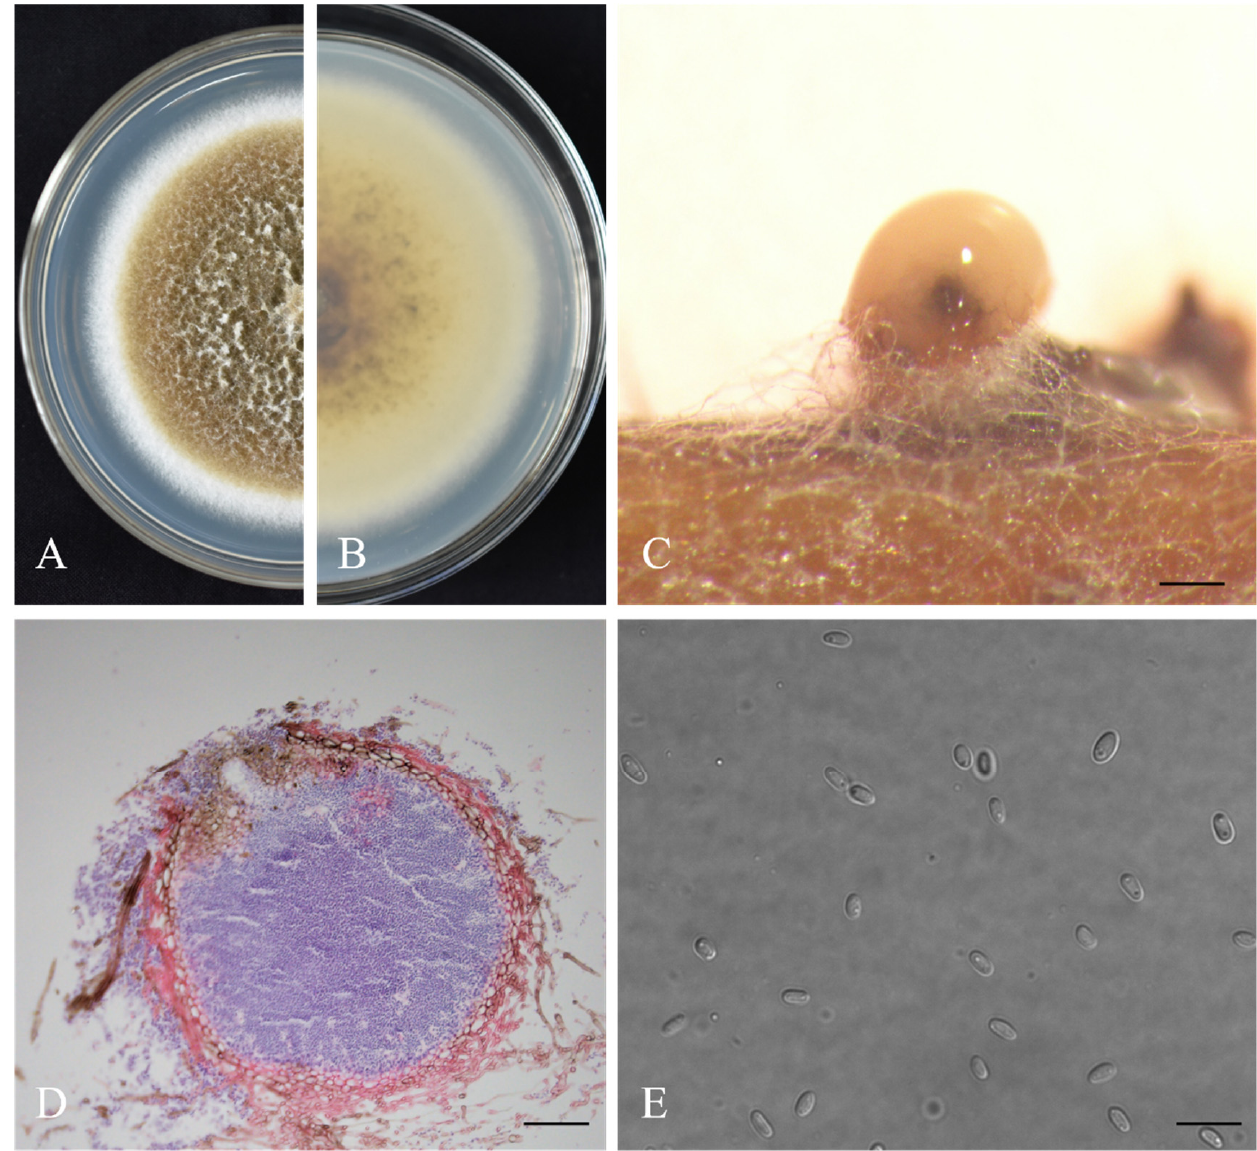
Figure 5. The morphologies of Didymella theifolia . ( A , B ) Front and back views of colonies cultured on PDA for 7 days, respectively. ( C ) Conidioma. ( D ) Section view of pycnidia. ( E ) Conidia. Scale bars indicate 200, 50, and 10 µm in panels ( C ), ( D ), and ( E ), respectively. MycoBank: MB Etymology. Named for the host plant, C. sinensis (L.) O. Ktze., from which the species was isolated.